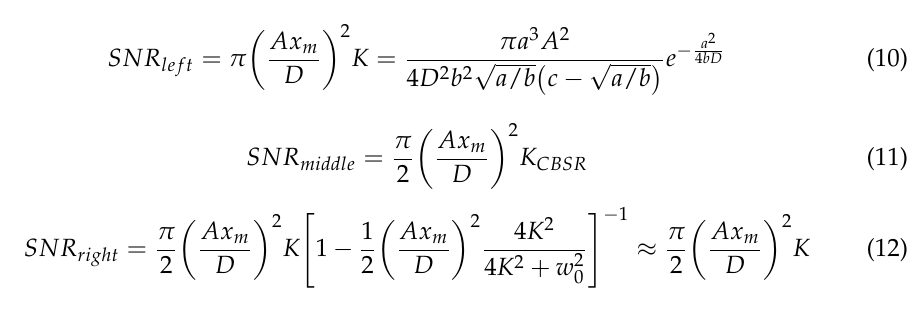
Figure 4. When b = 1, PNABSR’s potential function changes with parameters . ( a ) Potential func- tion changes with a ; ( b ) Potential function changes with a and x ;